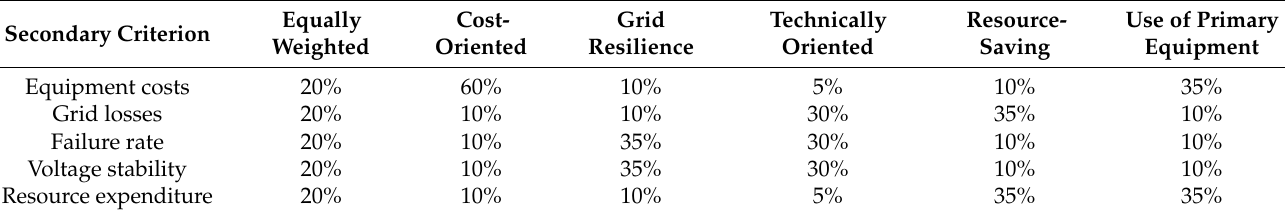
Table 7. Six different weightings for the secondary criteria.